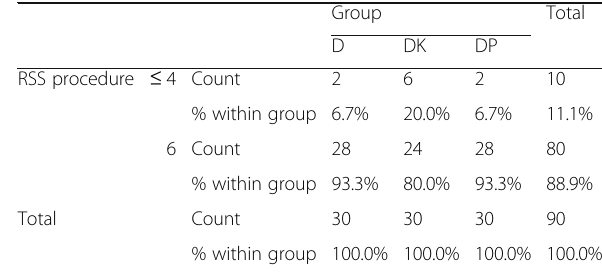
Table 9 Ramsay sedation score during the